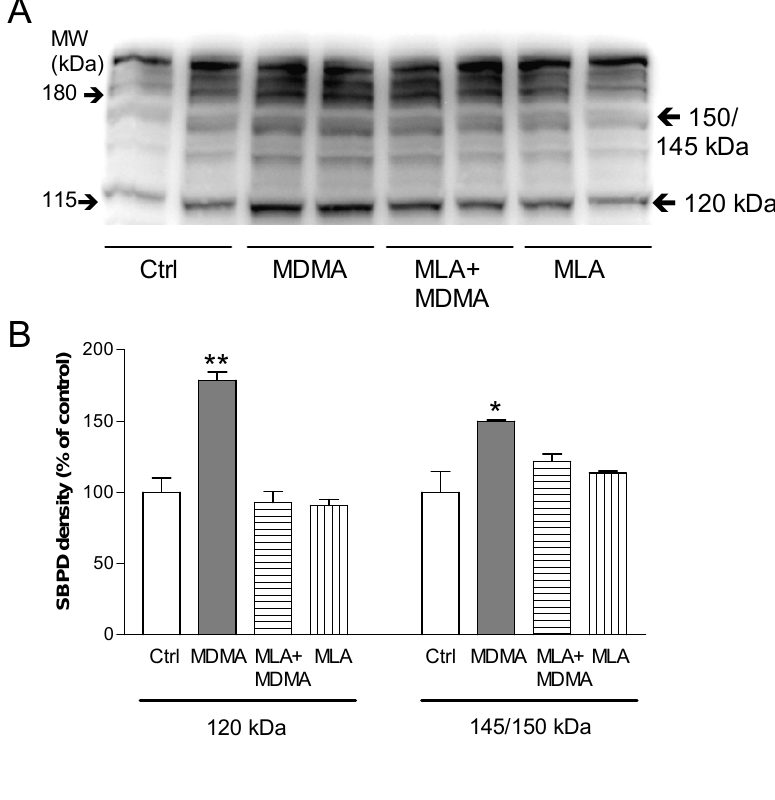
Figure 9. Representative Western blot of α -spectrin breakdown products (SBDP) originated by calpain activation (145 and 150 kDa) and capase 3 (120 and 150 kDa) after 24 h treatment with culture medium (Ctrl), MDMA (50 µM), MDMA + MLA (10 nM) and MLA alone. The localization of the molecular weight (MW) markers is shown on the left of the picture. B. Quantification of dot intensity of the SBDPs. Data are the means ± SEM of three different cultures, loaded in duplicates. * P < 0.05 and ** P < 0.001 vs . control. Reproduced from